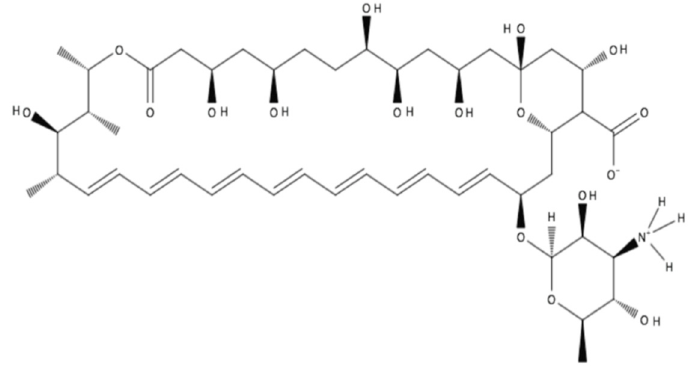
Figure 1. Structure of amphotericin B in zwitterionic form.